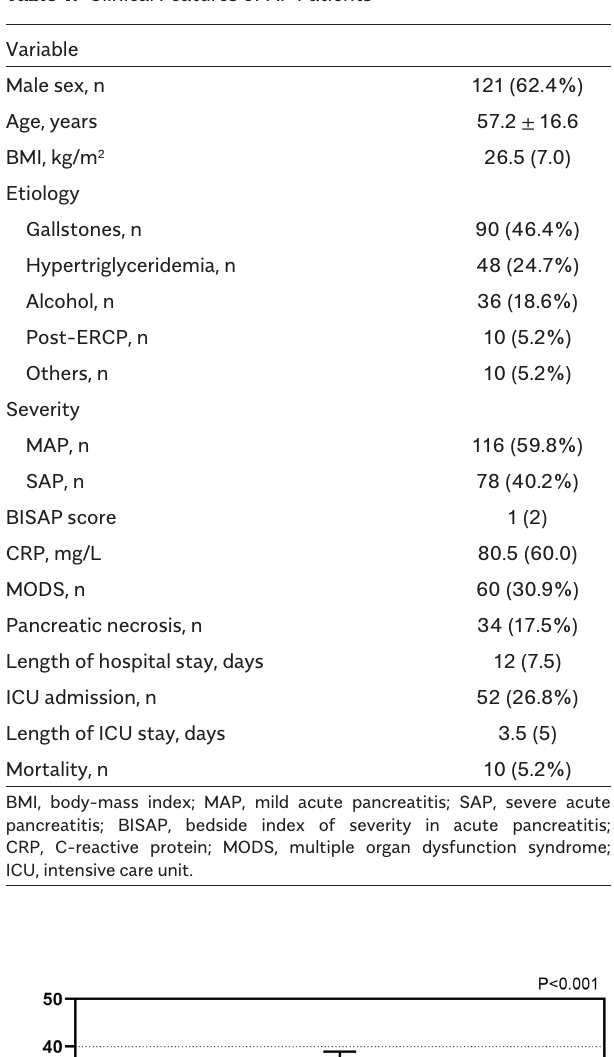
Table 1. Clinical Features of AP Patients